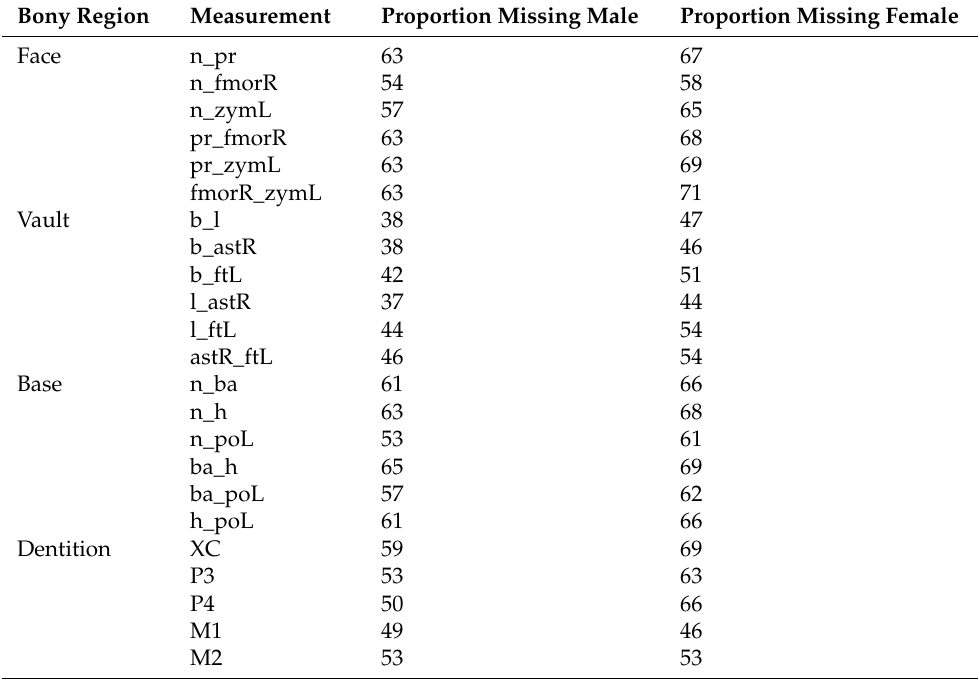
Table 3. Percentage of missing data for each